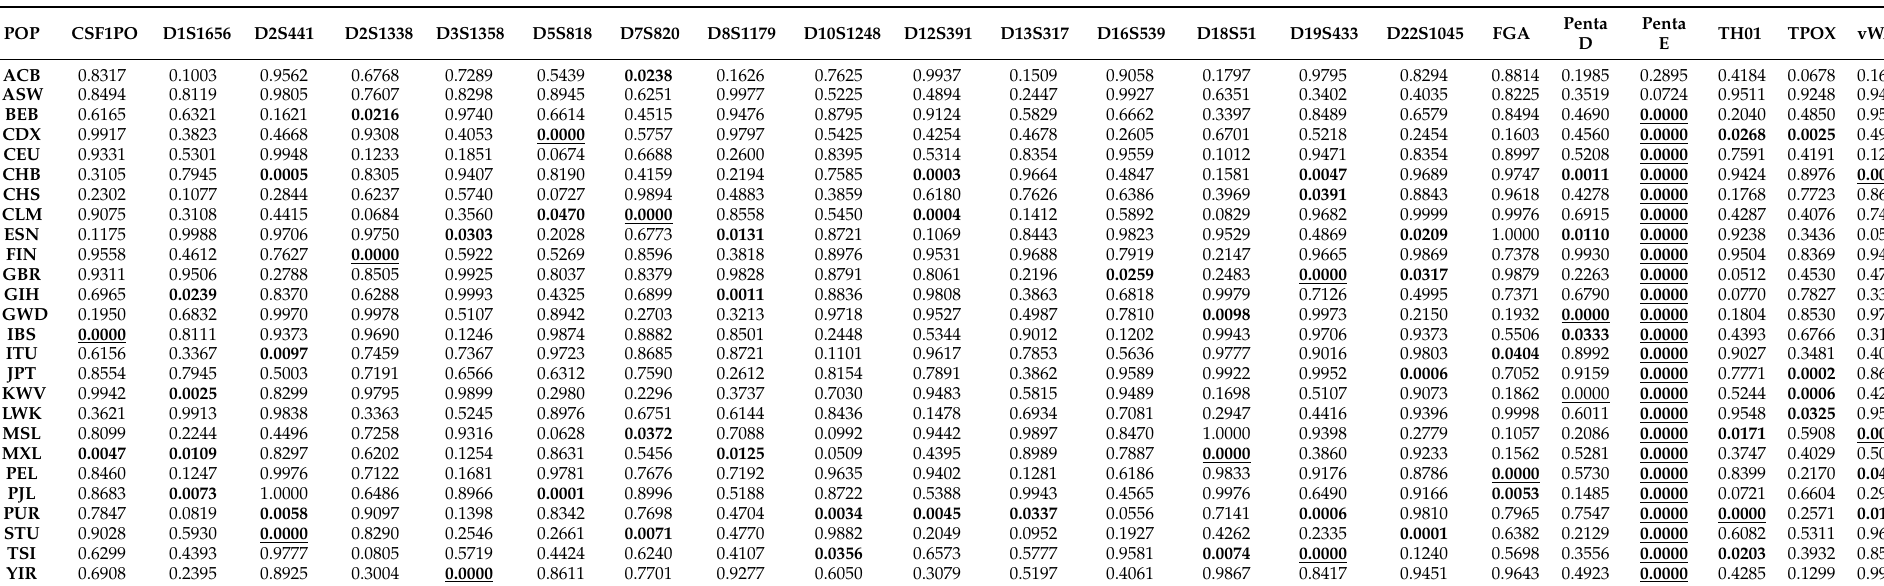
Table 3. Probabilities of adherence to Hardy-Weinberg equilibrium proportions for each STR in all the 26 subpopulations analyzed in the 1000 Genomes Project. Significant p -values ( α = 0.05) are in boldface. The probabilities that remained significant after the Bonferroni correction for multiple tests ( α BONFERRONI = 0.05/546 = 0.000092) are also